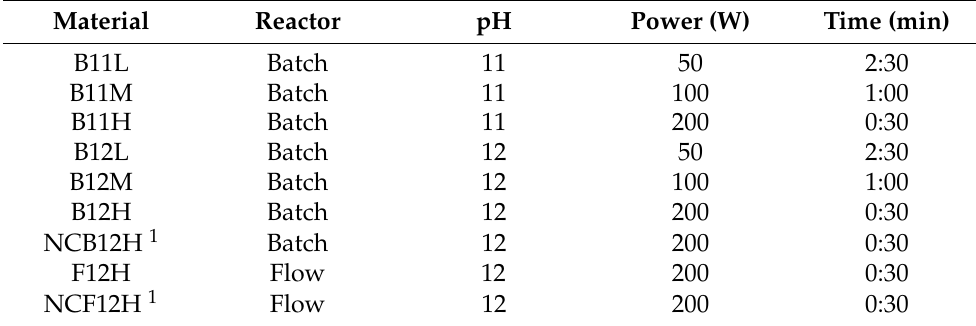
Scheme 1. Scheme describing the setup for the synthesis in batch and flow. Table 1. Summary of synthesis